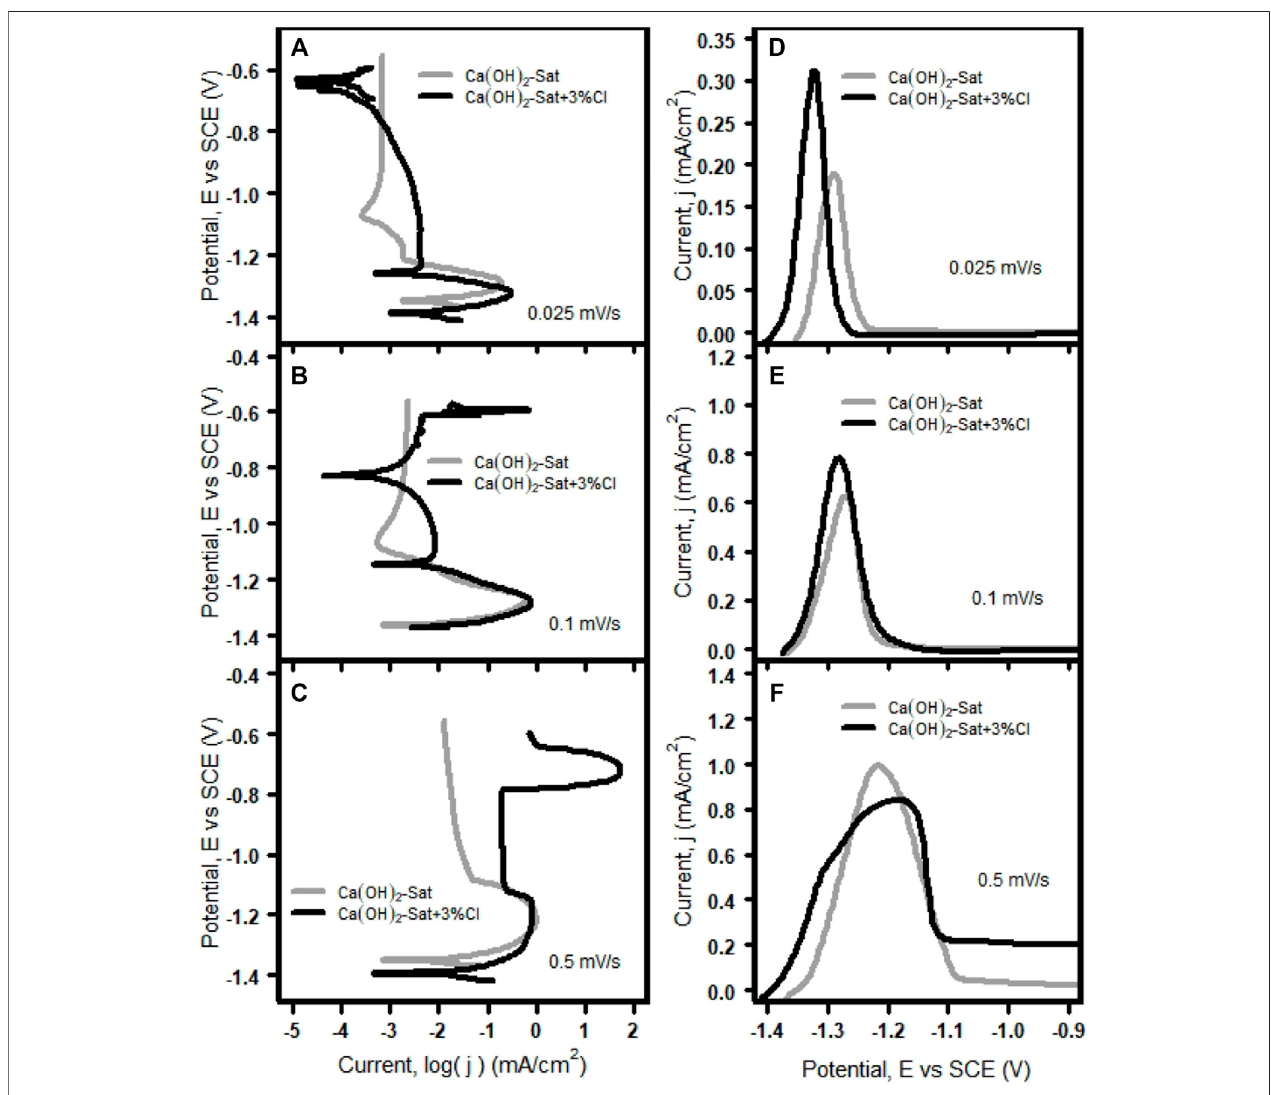
FIGURE 4 | Polarization curves of zinc plates in the two test solutions: E vs. log j at (A) 0.025 mV/s, (B) 0.1 mV/s, and (C) 0.5 mV/s, and j vs. E at (D) 0.025 mV/s, (E) 0.1 mV/s, and (F) 0.5 mV/s.